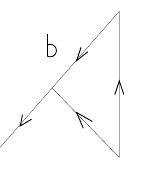
Fig. 5: weights in a fundamental domain